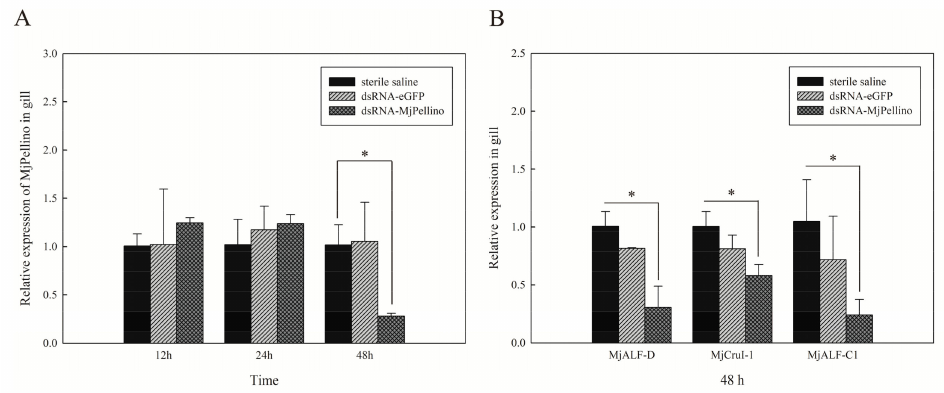
Figure 7. qRT-PCR analysis of MjPellino ( A ) and MjAMP ( B ) gene expression after the knockdown of MjPellino (* p <